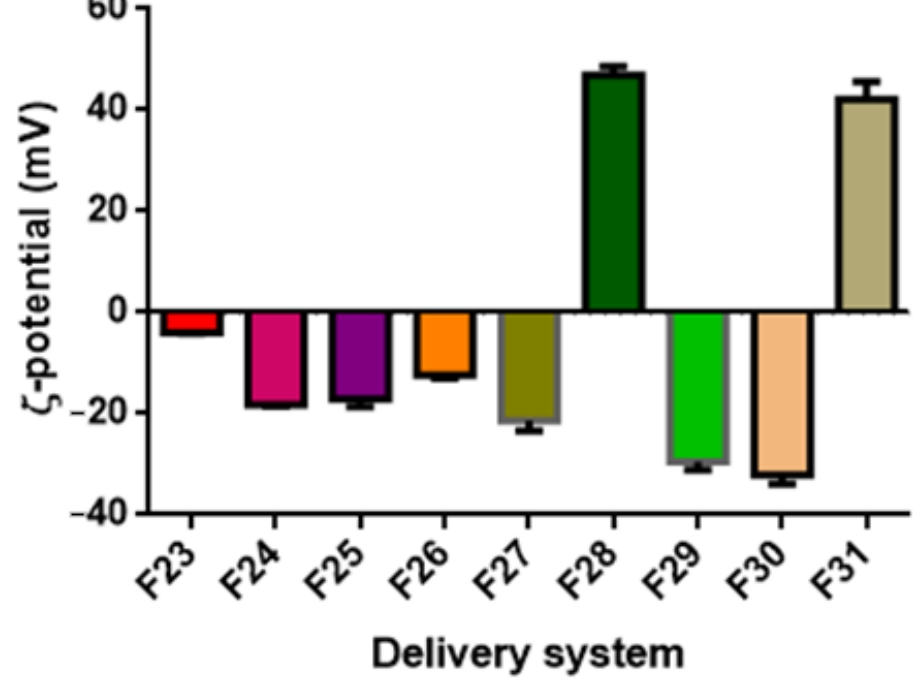
Figure 6. ζ -potential of TC2 EO nanoemulsions (formulations F14–F18) and nanoparticles (formula- tions F19–F22).